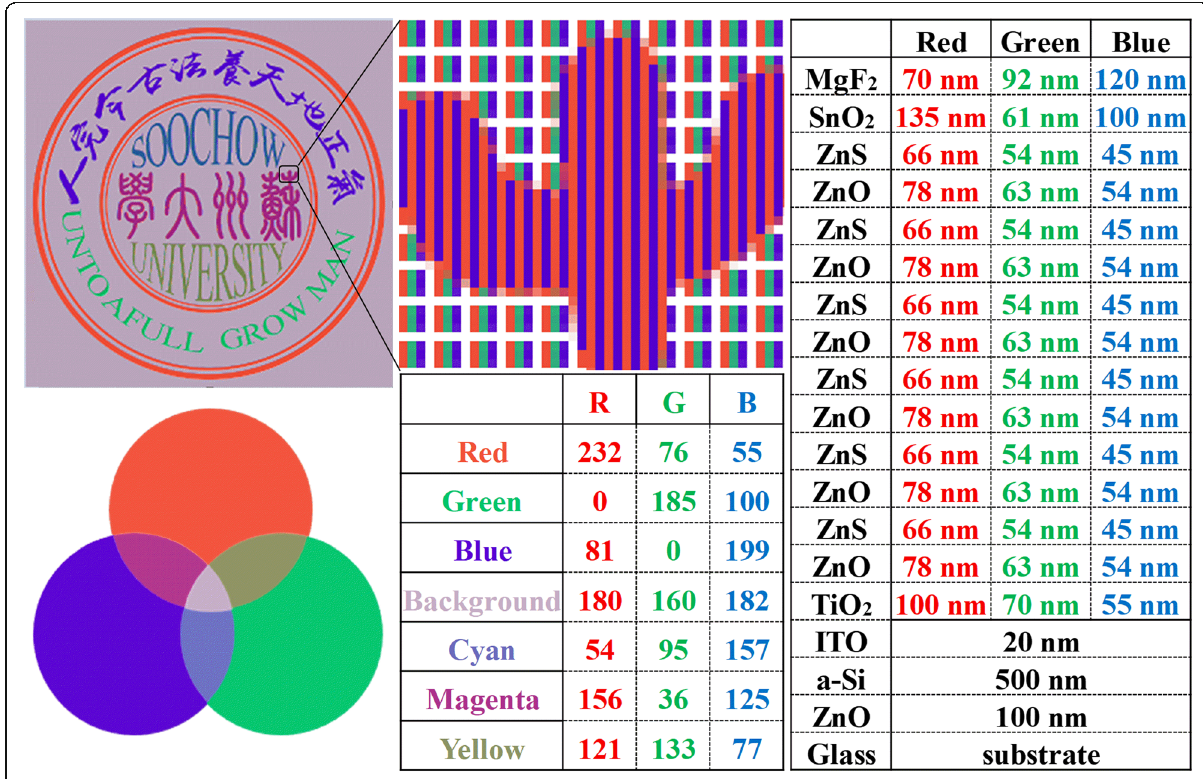
Fig. 4 Logo of Soochow University, with pixels composed of RGB a-Si:H SCs. The inset shows the microscopic pixel composition, the structure details of the RGB a-Si:H SCs, and the RGB values of color maps mixed by the three primary